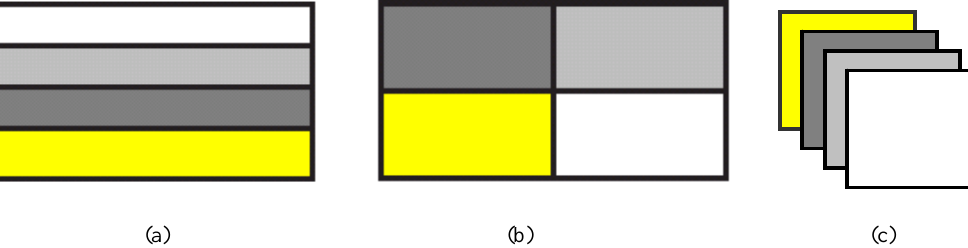
Fig. 1 The parallel proceeding mechanism